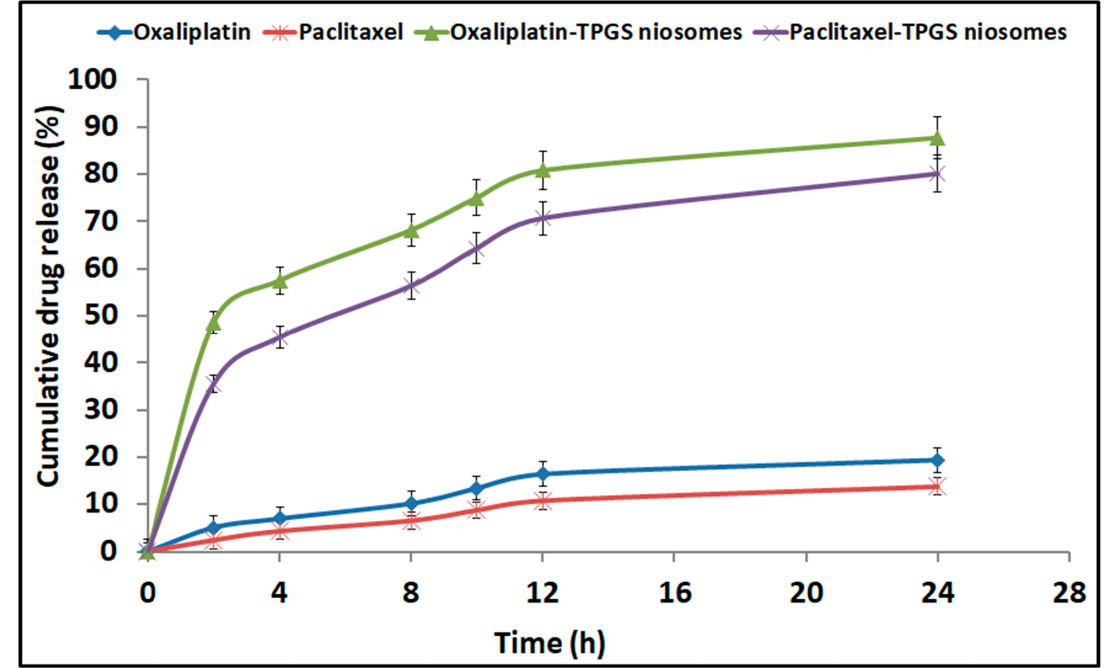
Figure 4. In vitro cumulative drug release profile from Oxaliplatin–TPGS niosomes, Paclitaxel–TPGS niosomes, Oxaliplatin free drug and Paclitaxel free drug. Table 4. Different mathematical models of in vitro release data (means ± SD, n = 3).